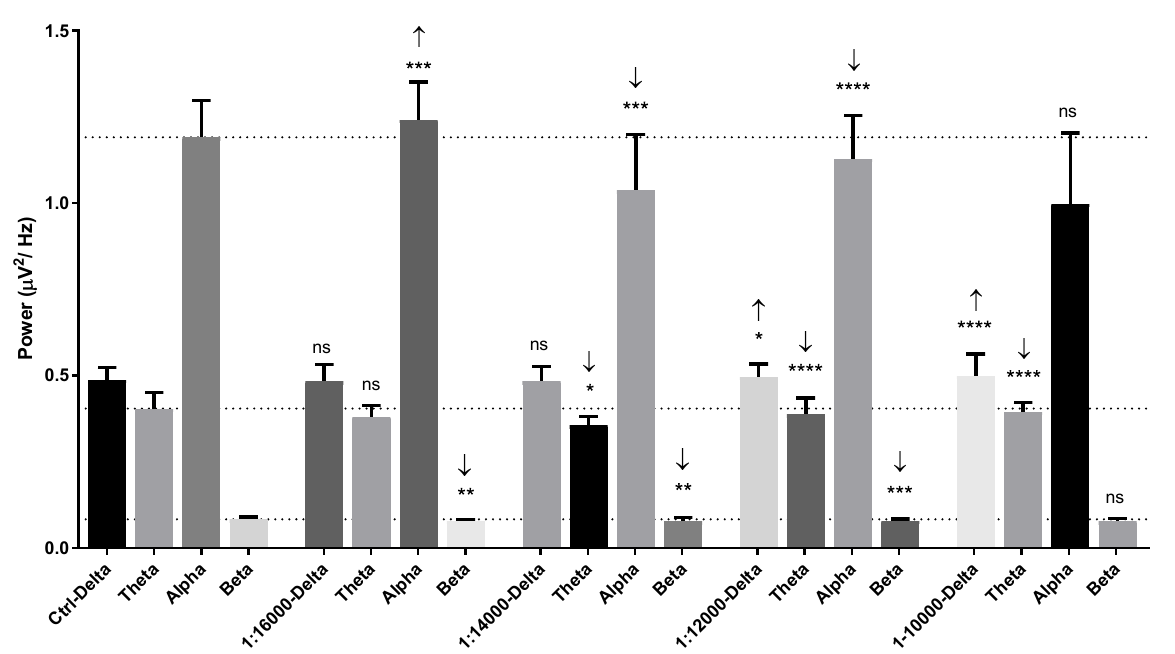
Figure 6. Power spectral analysis of human brainwaves characterized by frequencies consisting of delta, theta, alpha, and beta wave powers in control, 1:1000 dilution, 1:400 dilution, 1:100 dilution, and undiluted garlic oil groups. Not significant (ns), *, **, *** and **** represent no statistical differences, p < 0.05, and p < 0.01, p < 0.001, and p < 0.0001, respectively.